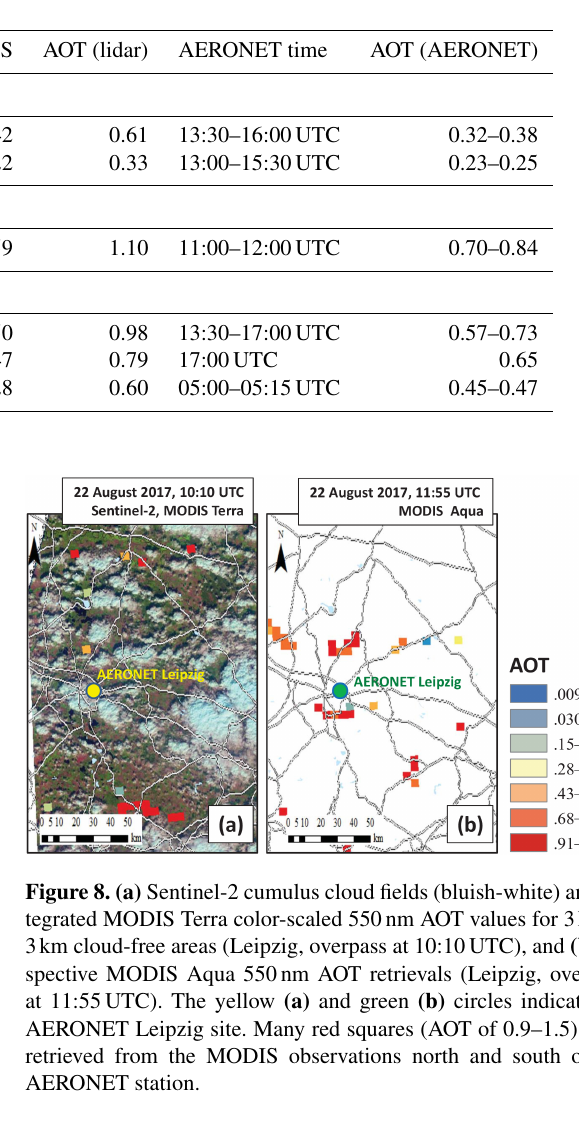
Table 2. Comparison of AOT measured with lidar (at 532nm) and the AERONET sun photometer (at 500nm) on 21–22 August 2017. AERONET Level 1.0 (Brno), 1.5 (Hohenpeissenberg, 21 August) and 2.0 (Leipzig, and Hohenpeissenberg, 22 August) are used in the table. AOT contributions of the planetary boundary layer (PBL), the free troposphere (FT), and the stratosphere (S) are also separately listed. In the lidar retrieval, a lidar ratio of 60sr (PBL) and 70sr (FT, S) is used. Brno is 115km southeast (1.5h downwind at a height of 15km on 22 August) of the Kosetice lidar site.